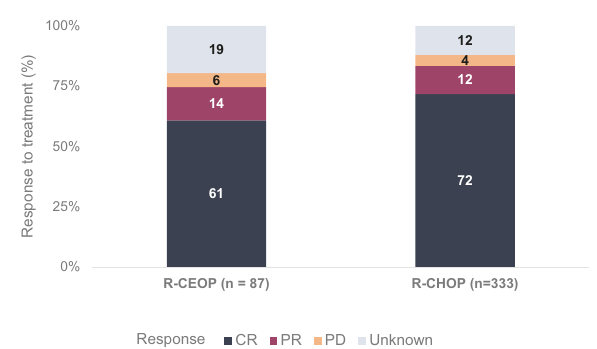
Fig. 1 Best observed response in patients with diffuse large B-cell lymphoma treated with R-CEOP and R-CHOP. Stacked bar graph depicting best response showing no signi fi cant difference in overall response in patients treated with RCEOPas compared to patients treated with R-CHOP ( p =